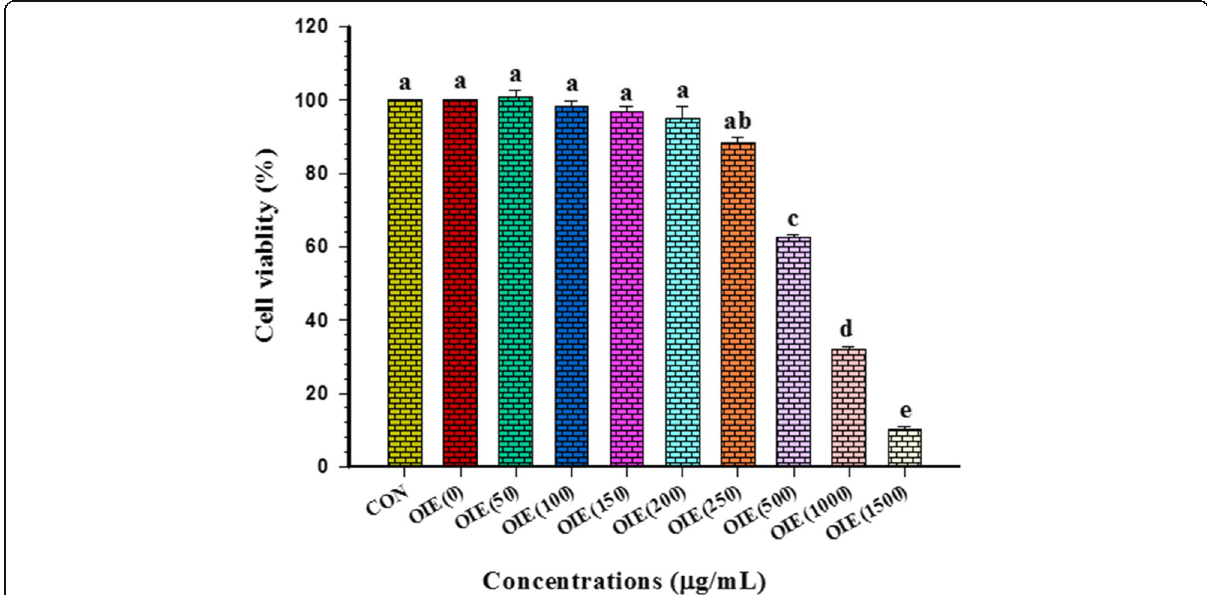
Fig. 1 Graphically represents the effect of Oroxylum indicum extract on the viability of 3T3-L1 preadipocytes. CON = vehicle control; OIE(50) = Oroxylum indicum at 50 μ g/mL. Values are Means ± SEM ( n = 3 replicates). A significant differences were observed (Tukey ’ s HSD test, p < 0.05) and are represented on the figure with letters from a to e. Bars annotated with the differrent letters are significantly different to the